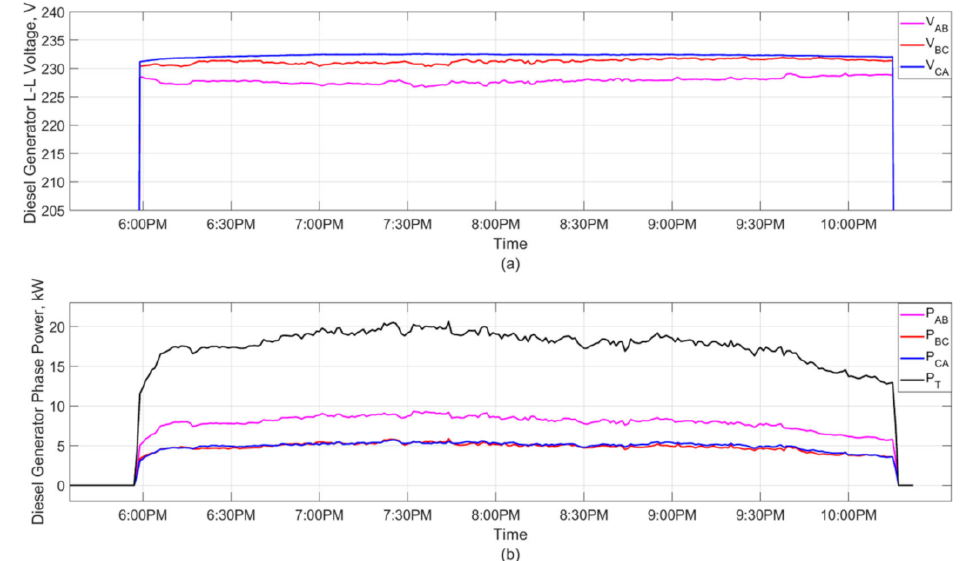
Figure 5. Gilutongan Island’s village diesel generator voltage and power on 23 May 2019: ( a ) Line-to- line voltages; ( b ) power per phase and the total power of the 3-phase